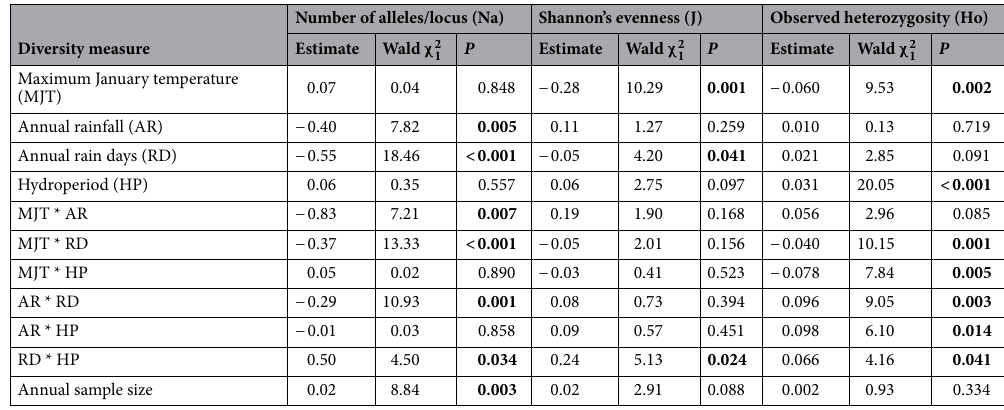
Table 1. The effect of maximum January temperature (C), annual rainfall (mm), number of rainy days (> 0.1 mm/day), and length of hydroperiod (days) on genetic diversity measures (mean number of alleles/ locus, Shannon’s information evenness, and observed heterozygosity). Mean number of alleles/locus and the four climatic variables were standardized within pool. Significant effects are indicated in bold.